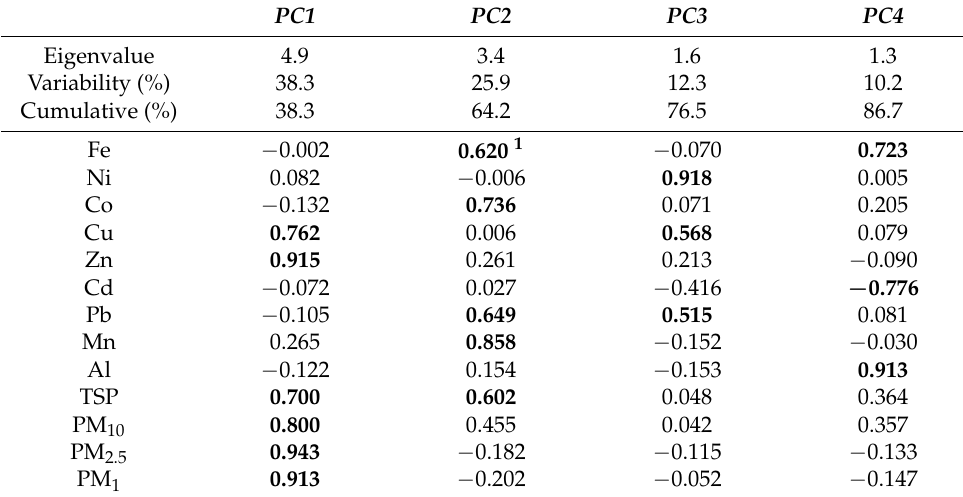
tributed to soil pollution. The PC4 explains 10.2% of the variability and groups the Fe and Table 2. Factor loadings of PC ’s after varimax rotation. Table 2. Factor loadings of PC ’s after varimax rotation.